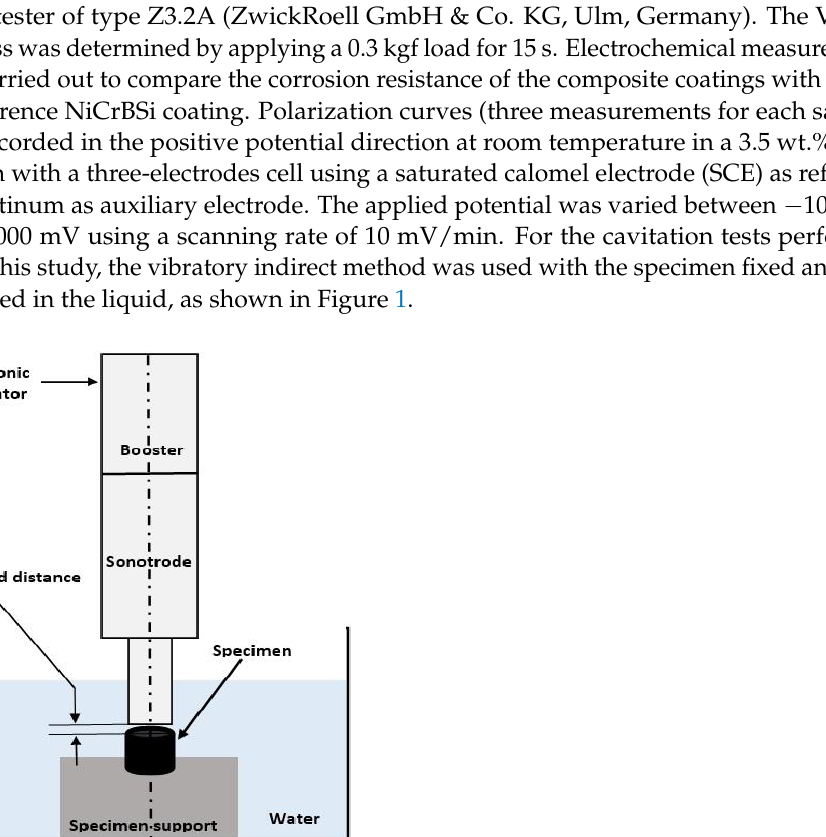
Table 1. Sample designation in respect to the powder mixture.